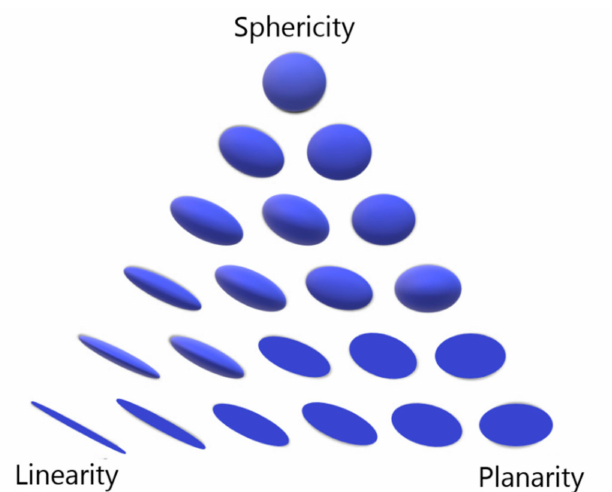
Figure 3. Ellipsoid representation of relationship between sphericity, linearity, and planarity (after